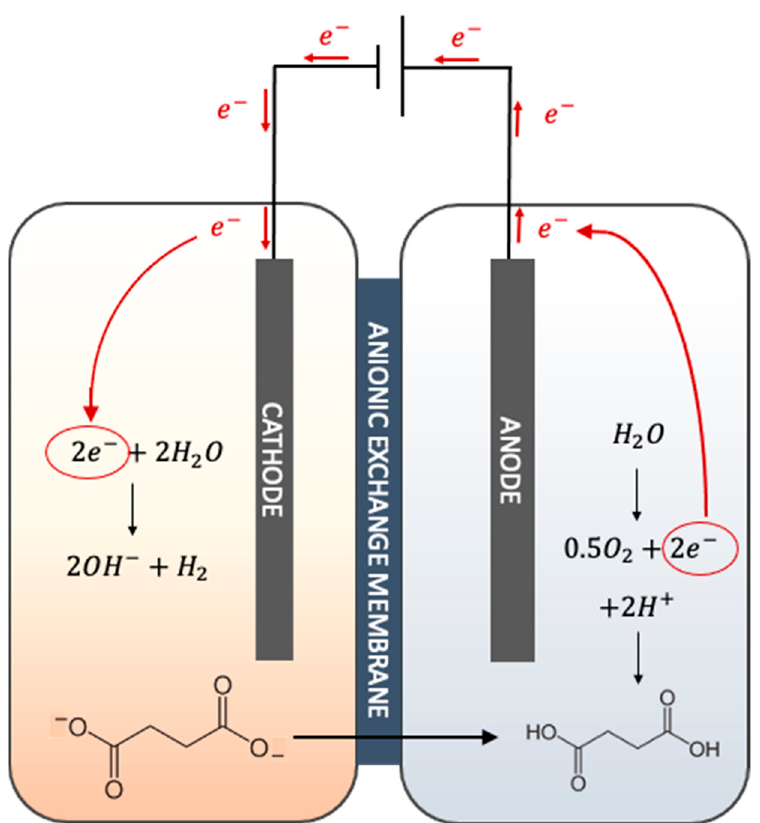
Figure 1. Schematic representation of succinic acid extraction in an electrolytic cell. The negatively charged succinate in the cathode chamber is driven through an anionic exchange membrane into the anode chamber where it is protonated to succinic acid. The applied voltage is the driving force that as a side effect brings about electrolysis of water to produce molecular hydrogen and hydroxide ions at the cathode and oxygen and protons at the anode side of the membrane.